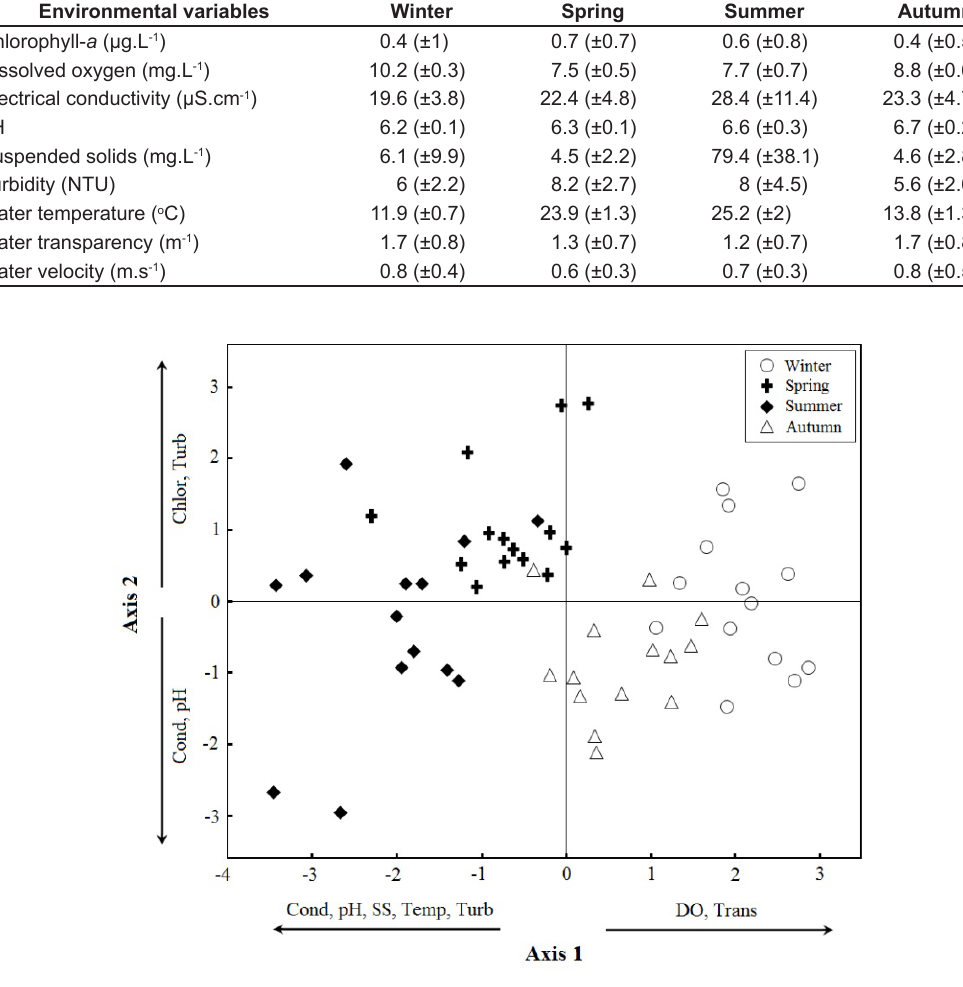
Figure 2. Principal Component Analysis (PCA) ordination showing the environmental differences for each season in the Pelotas River sub-basin (abbreviations: Trans, water transparency; DO, dissolved oxygen; SS, Suspended solids; Chlor, chlorophyll- a ; Cond, electrical conductivity; Temp, water temperature; Turb,